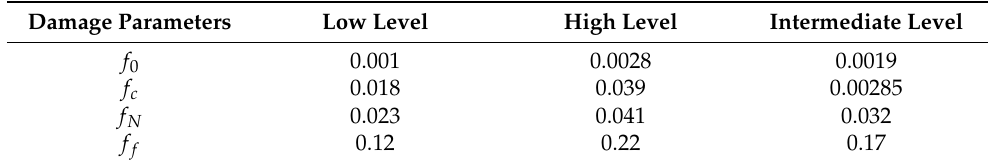
Table 4. Range of values of damage parameters.